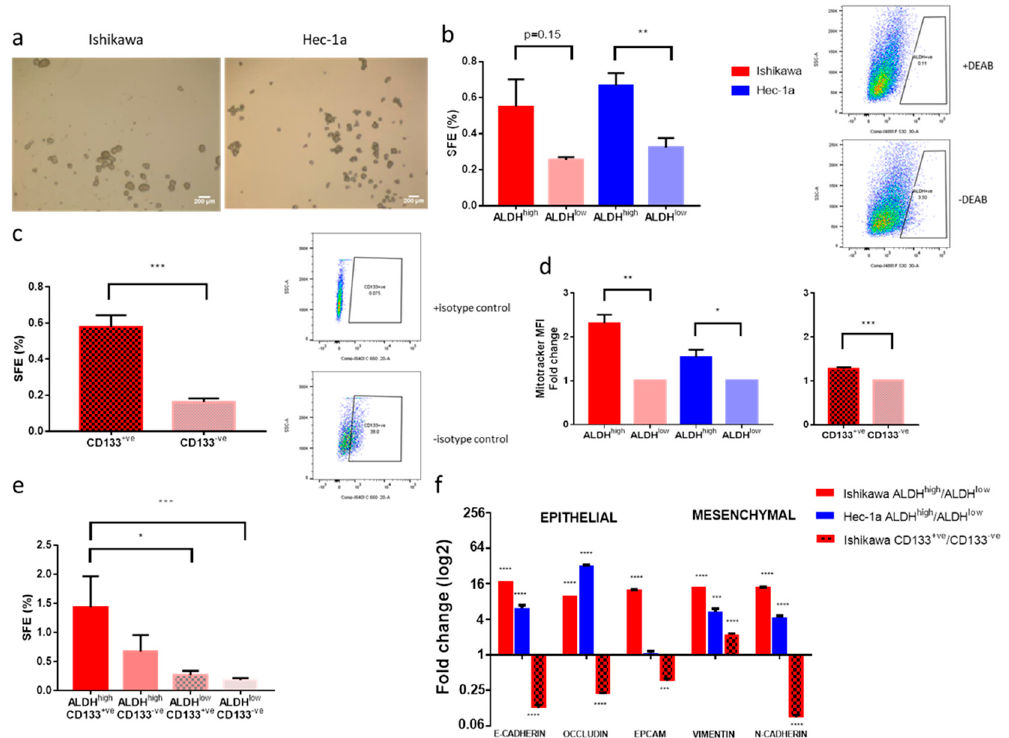
Figure 1. Characterisation of endometrial cancer stem cells in two cell lines. ( a ) images at × 40 magnification of ‘spheres’ formed under non-adherent conditions by two endometrial cancer cell lines. ( b ) On the left, sphere formation e ffi ciency (SFE) of Ishikawa and Hec-1a cells with high and low aldehyde dehydrogenase (ALDH) activity ( n = 3). On the right, a representative example of flow cytometry and gating for ALDH high cells using diethylaminobenzaldehyde (DEAB), an ALDH inhibitor. ( c ) On the left, SFE of CD133 + ve and CD133 -ve Ishikawa cells ( n = 3). On the right, a representative example of flow cytometry and gating for CD133 + ve cells using an isotype control antibody. ( d ) On the left, mitochondrial mass of Ishikawa and Hec-1a cells with high and low ALDH activity and, on the right, mitochondrial mass of CD133 positive and negative Ishikawa cells ( n = 3). ( e ) SFE of Ishikawa cells dual stained for ALDH activity and CD133 positivity ( n = 4). ( f ) qRT-PCR of genes associated with an epithelial and mesenchymal phenotype in ALDH high and CD133 + ve cells ( n = 3). Data are represented as means ± SEM. * p ≤ 0.05, ** p ≤ 0.01, *** p ≤ 0.001.